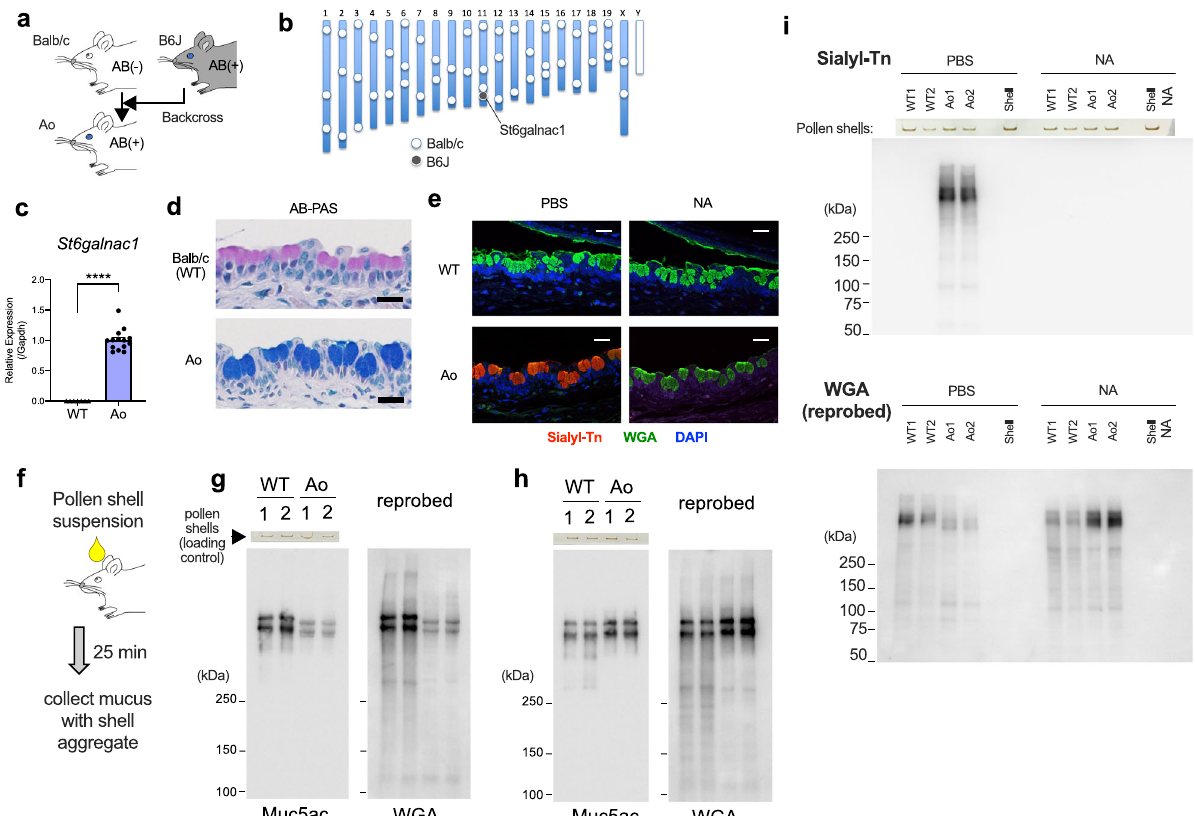
Fig. 4 | Expression of intact St6galnac1 restores Sialyl-Tn expression in con- junctival goblet cell mucins in vivo. a Schematic representation of backcrossing of B6J-derived intact St6galnac1 gene to Balb/c mice. b Chromosomal distribution ofPCR-con fi rmedstrain-speci fi cmarkersinAomice. c Intact St6galnac1 expression in the conjunctiva. n =7 for WT and n =14for Aomice. **** p <0.0001 by two-tailed Mann – Whitney test. Error bar represents S.E.M. d AB-PAS staining of the con-